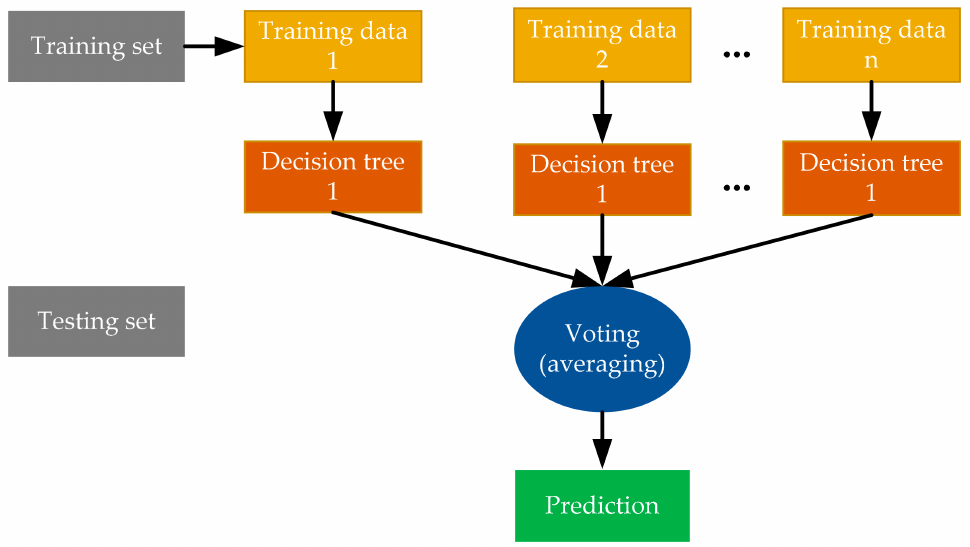
Figure 1. Schematic illustration of RF